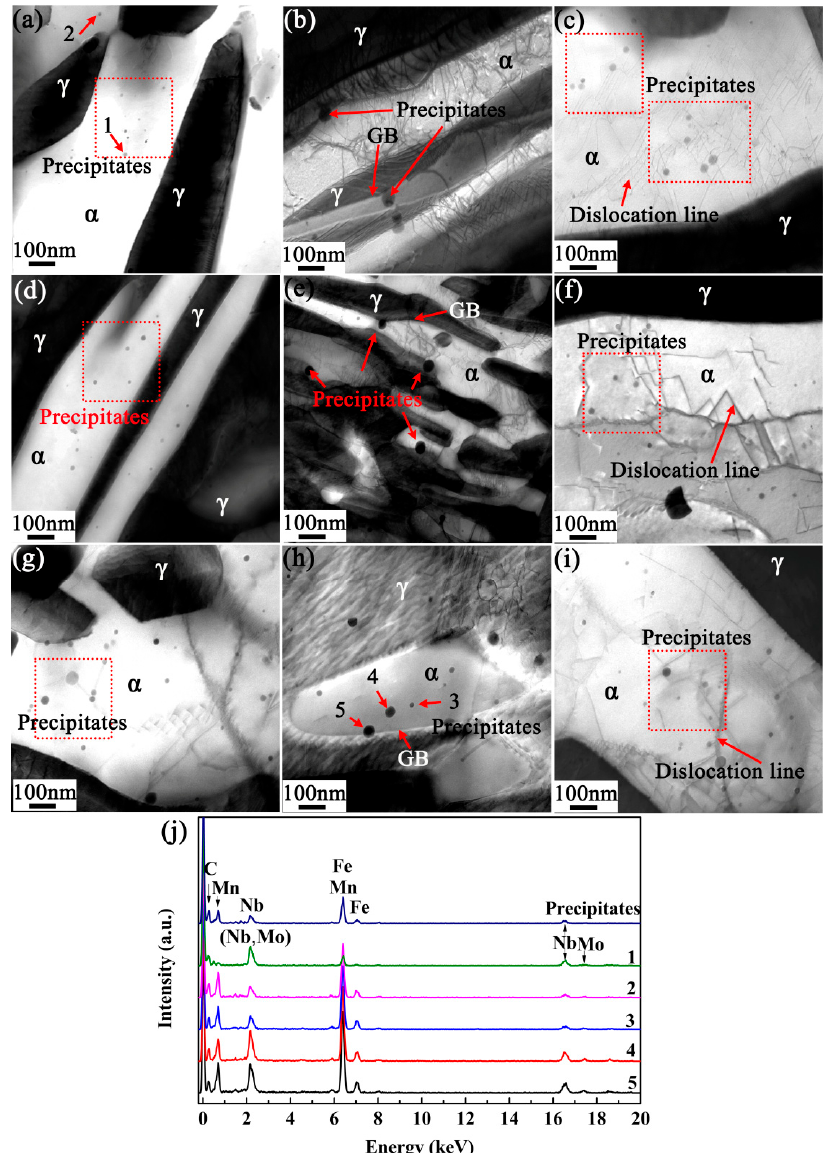
Figure 8. TEM image of precipitates in experimental steels: ( a–c ) CQ1-ART sample, ( d–f ) CQ2-ART Figure 8. TEMimageofprecipitatesinexperimentalsteels: ( a – c )CQ1-ARTsample,( d – f )CQ2-ARTCQ1-ART CQ1-ART sample, ( g–i ) CQ3-ART CQ1-ART sample and ( j ) precipitate TEM-EDS results (GB: grain sample, ( g – i ) CQ3-ART CQ1-ART sample and ( j ) precipitate TEM-EDS results (GB: grain boundary).